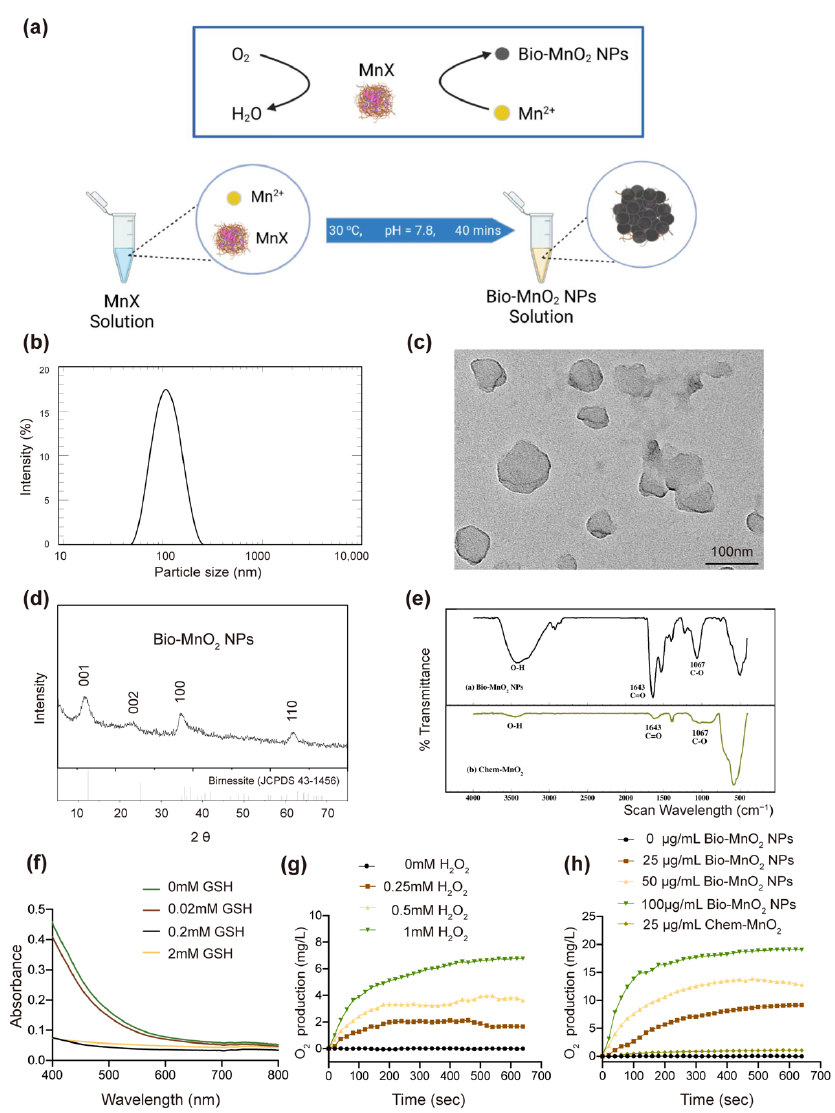
Figure 1. Characterization of biomineralized manganese oxide nanoparticles (Bio-MnO 2 NPs). ( a ) Fabrication of Bio-MnO 2 NPs via MnxEFG mediated biomineralization. ( b ) dynamic light scattering (DLS) measurement of size of Bio-MnO 2 NPs. ( c ) transmission electron microscopy (TEM) of NPs formed by biomineralization of MnxEFG. ( d ) X-ray diffraction (XRD) patterns for Bio-MnO 2 NPs